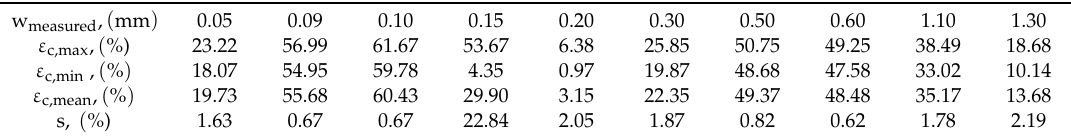
Table 3. Relative errors ε c for the corresponding crack